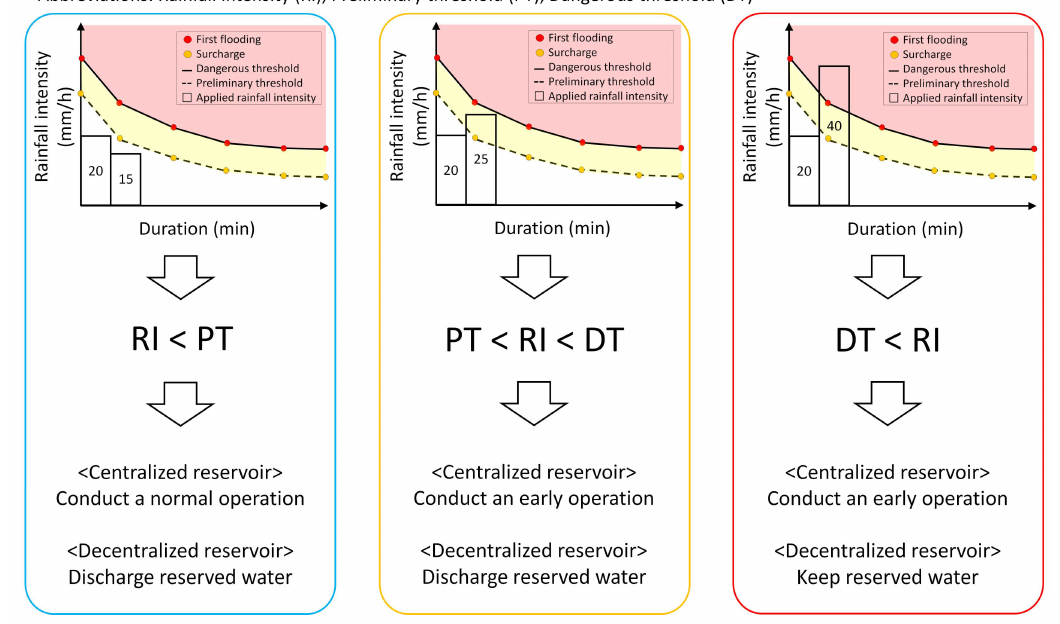
Figure 4. Schematic of an advanced operation in